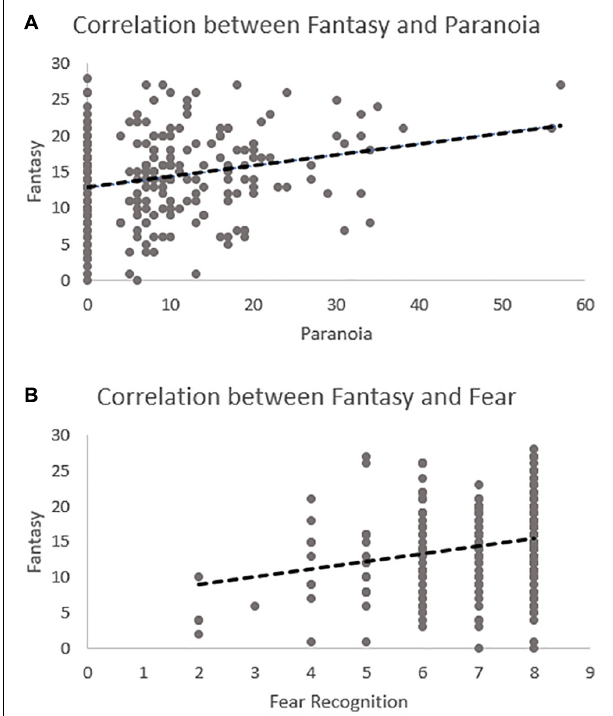
FIGURE 2 | Scatterplots demonstrating the significant relationship in the model between Fantasy and paranoia (A) and Fantasy and fear recognition (B)